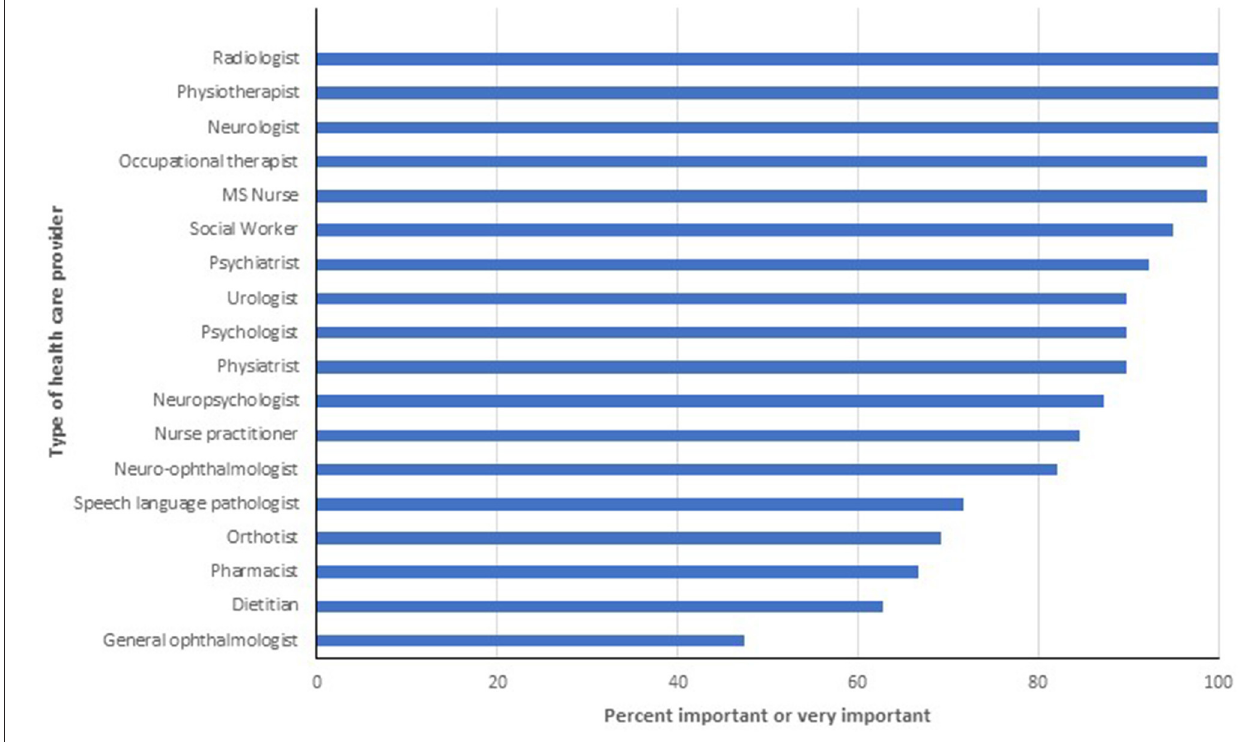
FIGURE 4 | Percentage of respondents indicating provider is important or very important for high quality multiple sclerosis